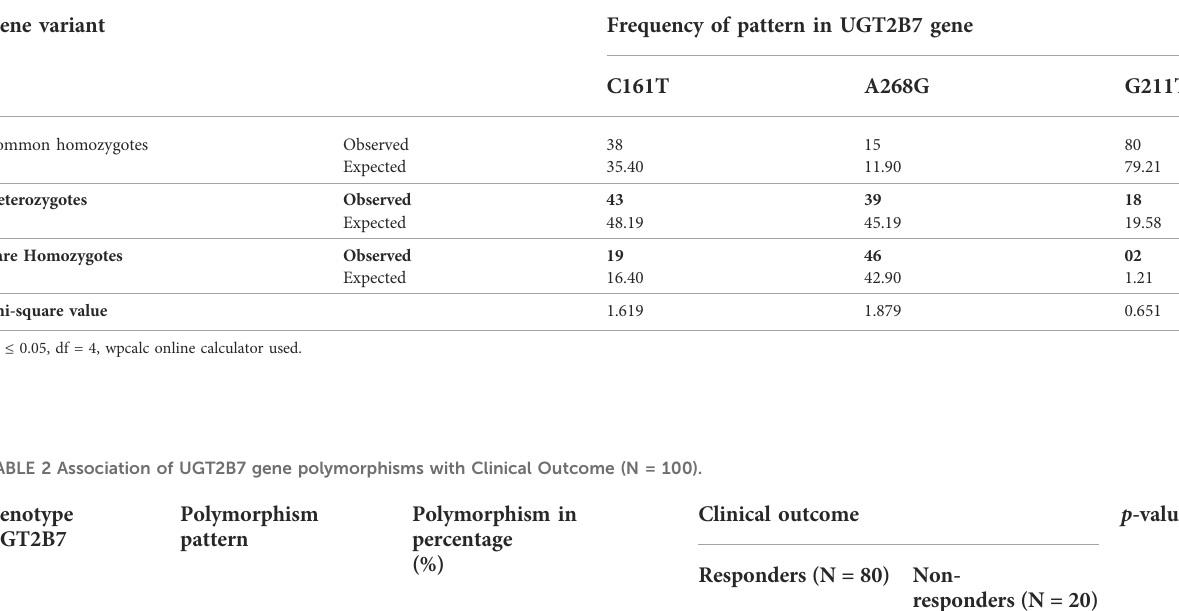
TABLE 1 Hardy Weinberg Equilibrium for UGT2B7 gene.